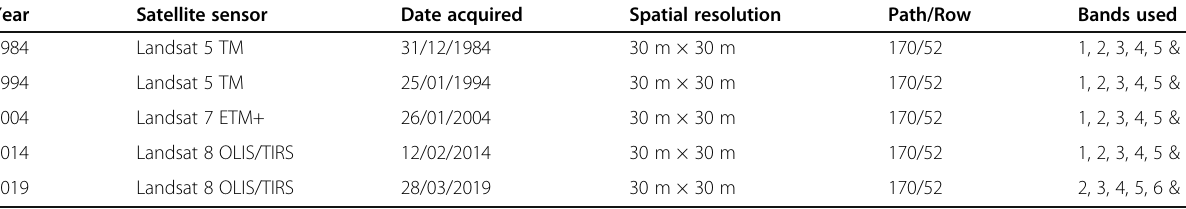
Table 1 Description of satellite image data that are used for the land use/land cover study of Bahir Dar City Year Satellite